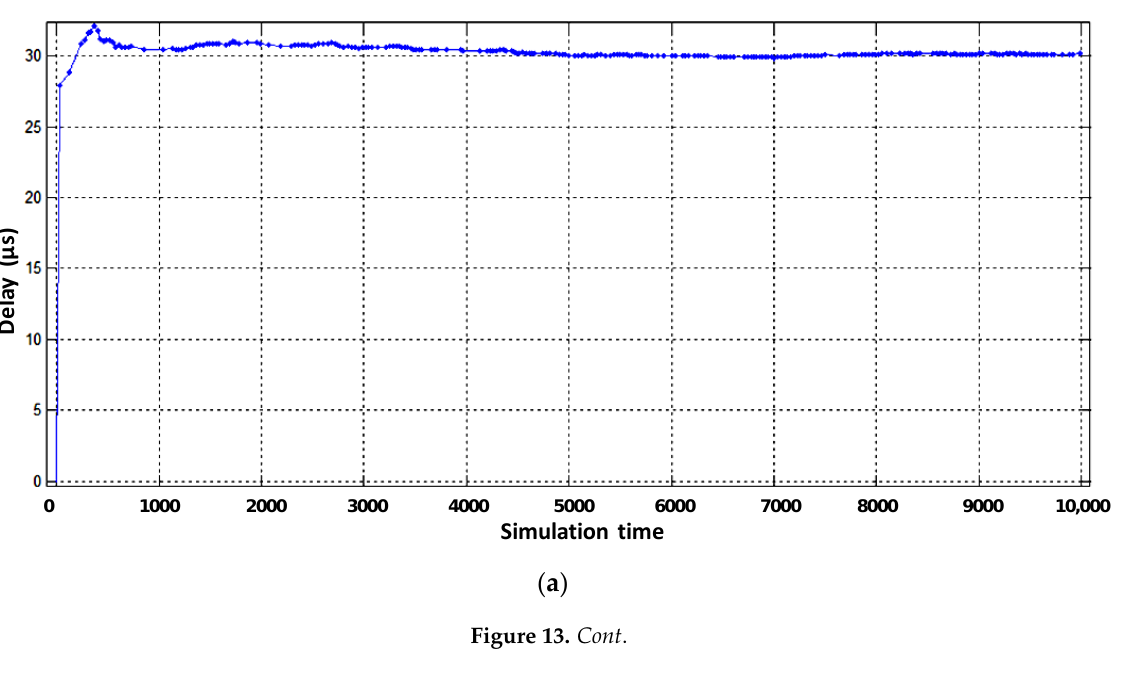
Figure 12. Delay of physical router buffering when serving aggregated flow.